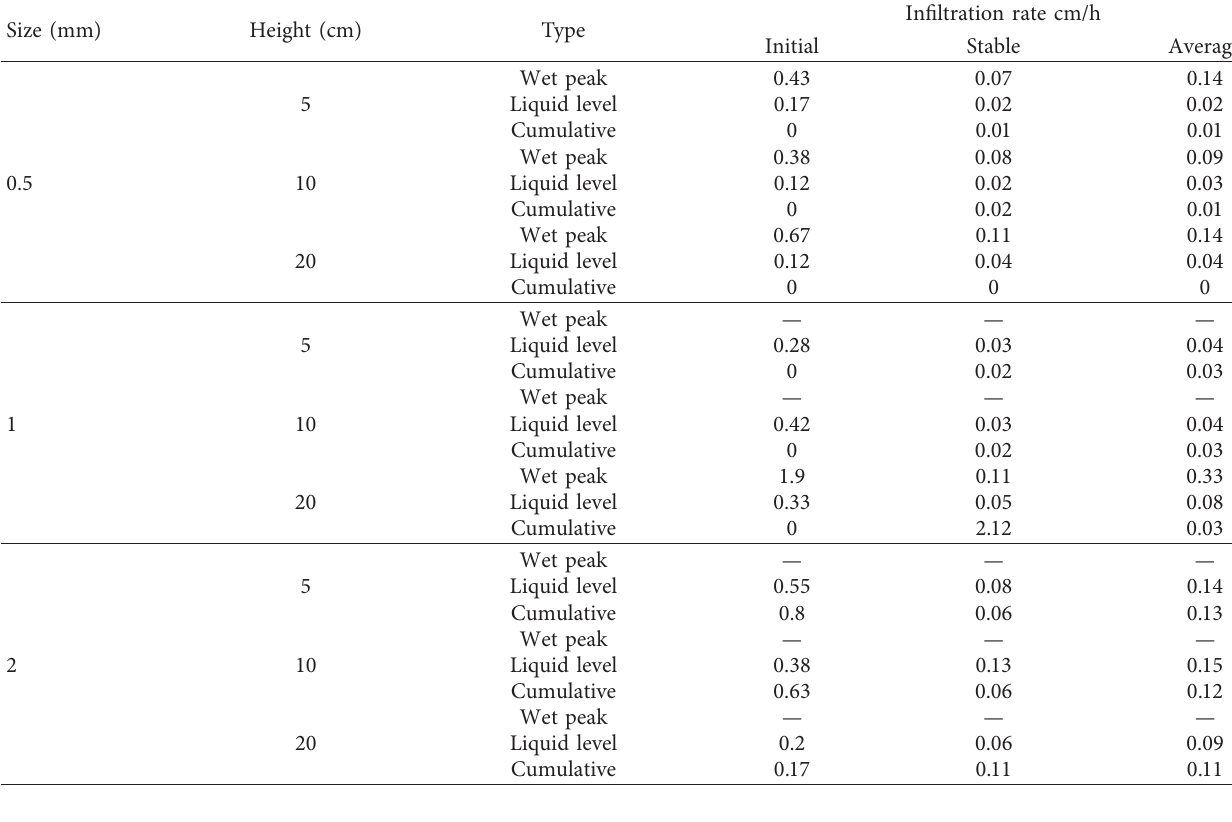
Table 3: Summary of experimental data processing results.